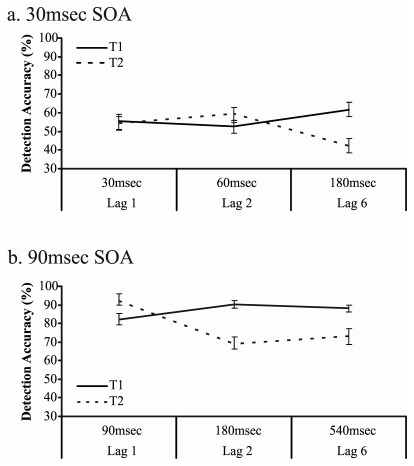
Target detection accuracy for T1 and T2 across the three lag conditions.(a) displays the 30 msec SOA trials. (b) displays the 90 msec SOA trials. The time points displayed on the x-axis are times between T1 onset and T2 onset. Error bars show standard errors of the mean.